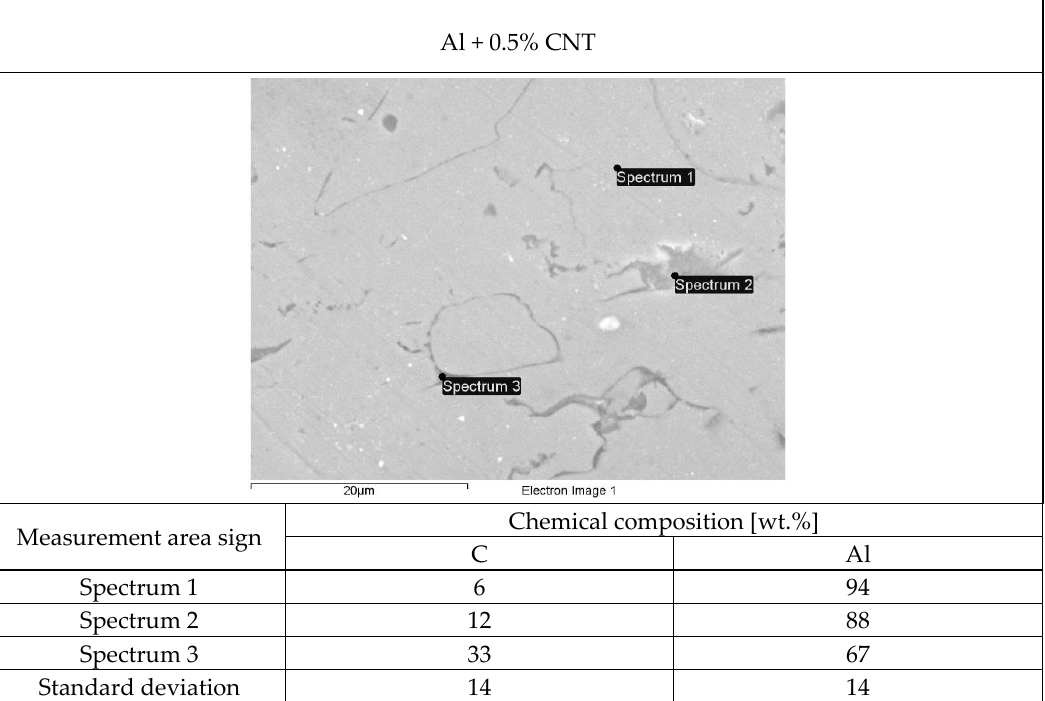
Figure 7 . The structure of aluminum powder with 0.5 wt.% Nanocyl NC 7000 carbon nanotubes flame-sprayed coating with marked chemical composition tested areas on SEM .